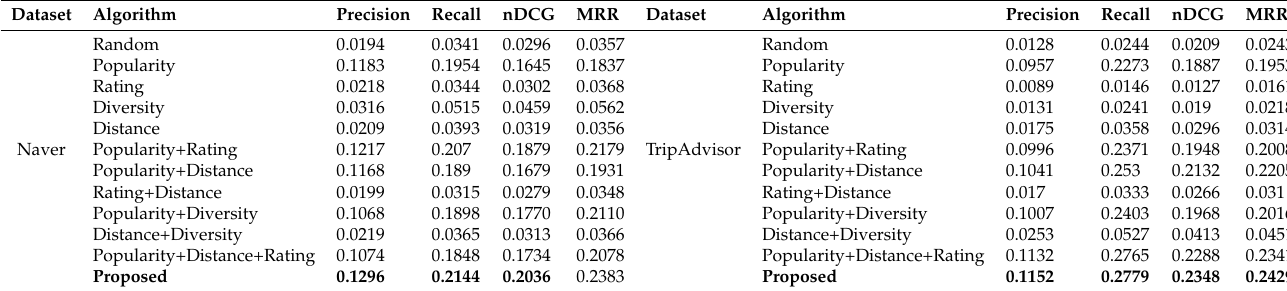
Table 7. Top 3 recommendation accuracy